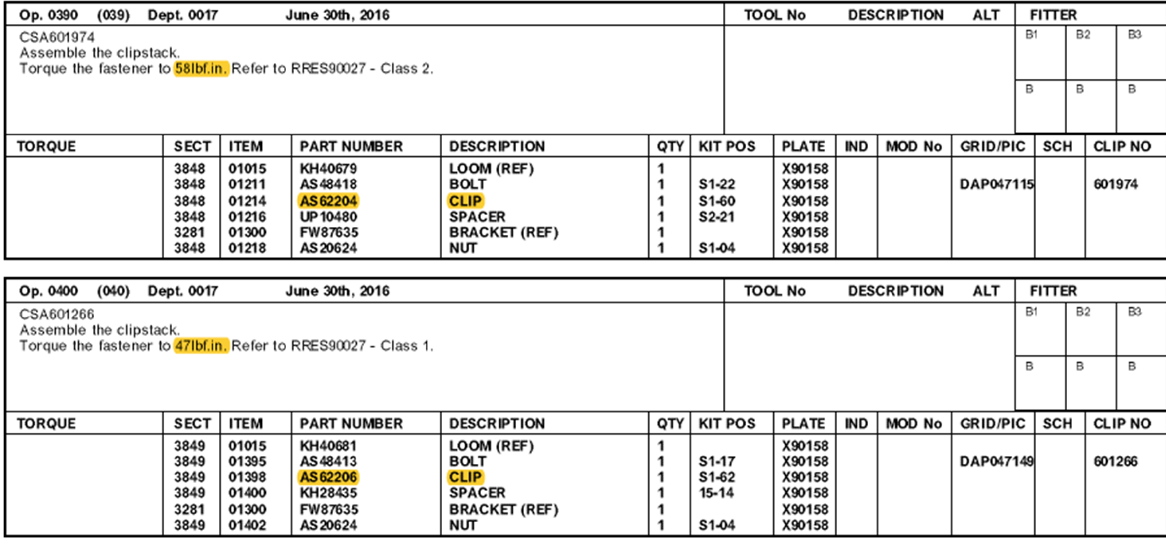
Figure 8. An SOP that consists of two different clip numbers.